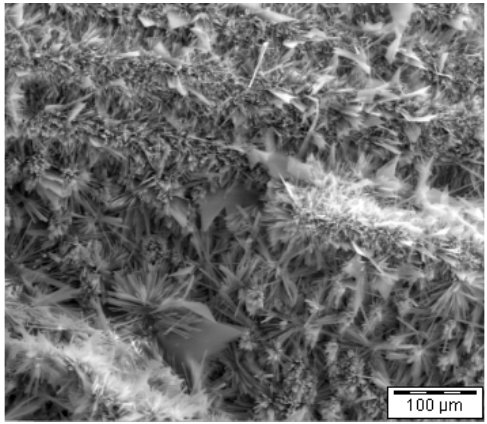
Figure 13. Dehydrated crystal of Figure 9a, rehydration.